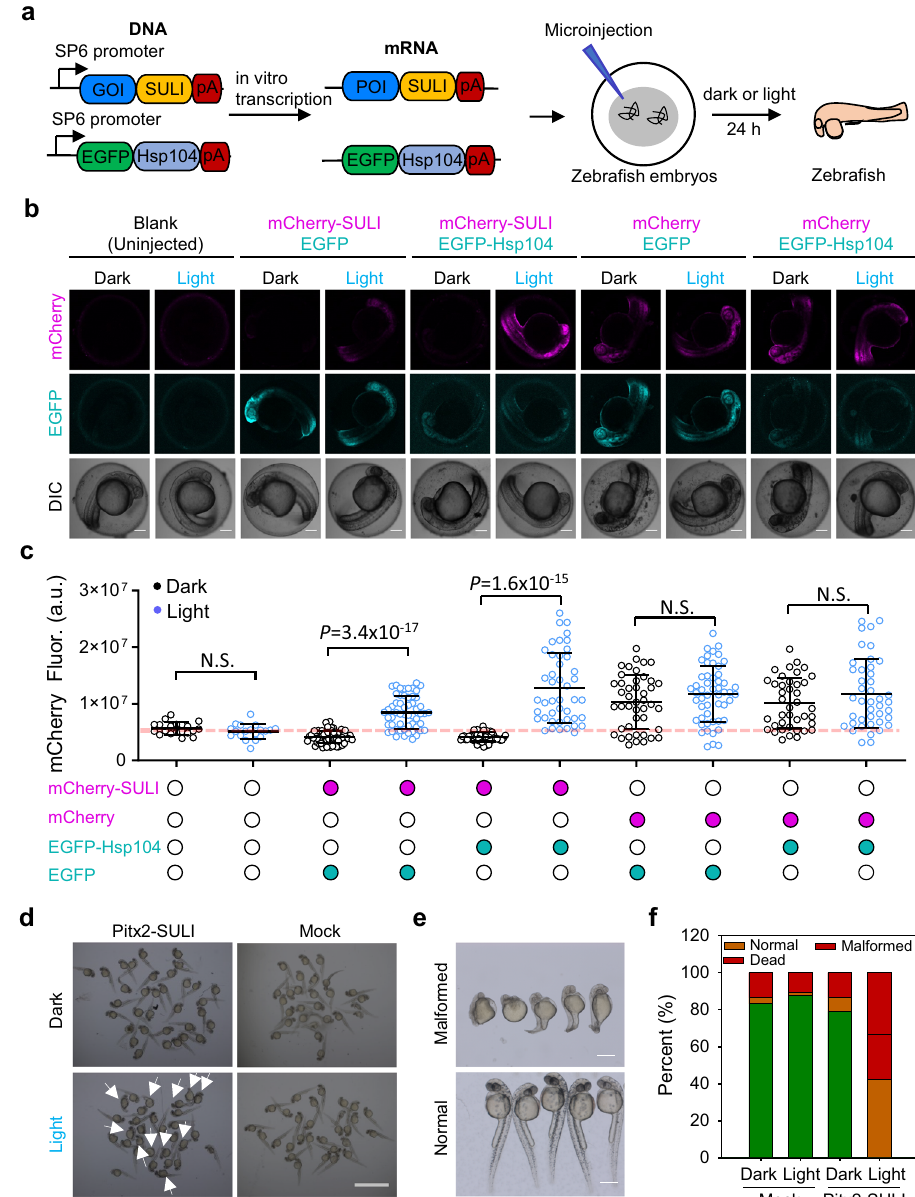
Fig. 6 | Optical control of protein stability by SULI in zebra fi sh . a Schematic representation of SULI-mediated degradation of the protein of interest (POI) in zebra fi sh embryos. mRNA encoding SULI fused with a protein of interest was transcribed in vitro using the SP6 promoter and injected into the zebra fi sh embryos. b ImageofmCherryandEGFP fl uorescenceinzebra fi shembryosinjected with mRNAs encoding mCherry-SULI and EGFP or EGFP-Hsp104. mRNA encoding mCherry alone was used to replace mCherry-SULI as the control. All the zebra fi sh embryos were incubated in E3 medium supplemented with 5 μ M FAD. Scale bar, 200 μ m. c QuantitativeanalysisofmCherry fl uorescenceinzebra fi